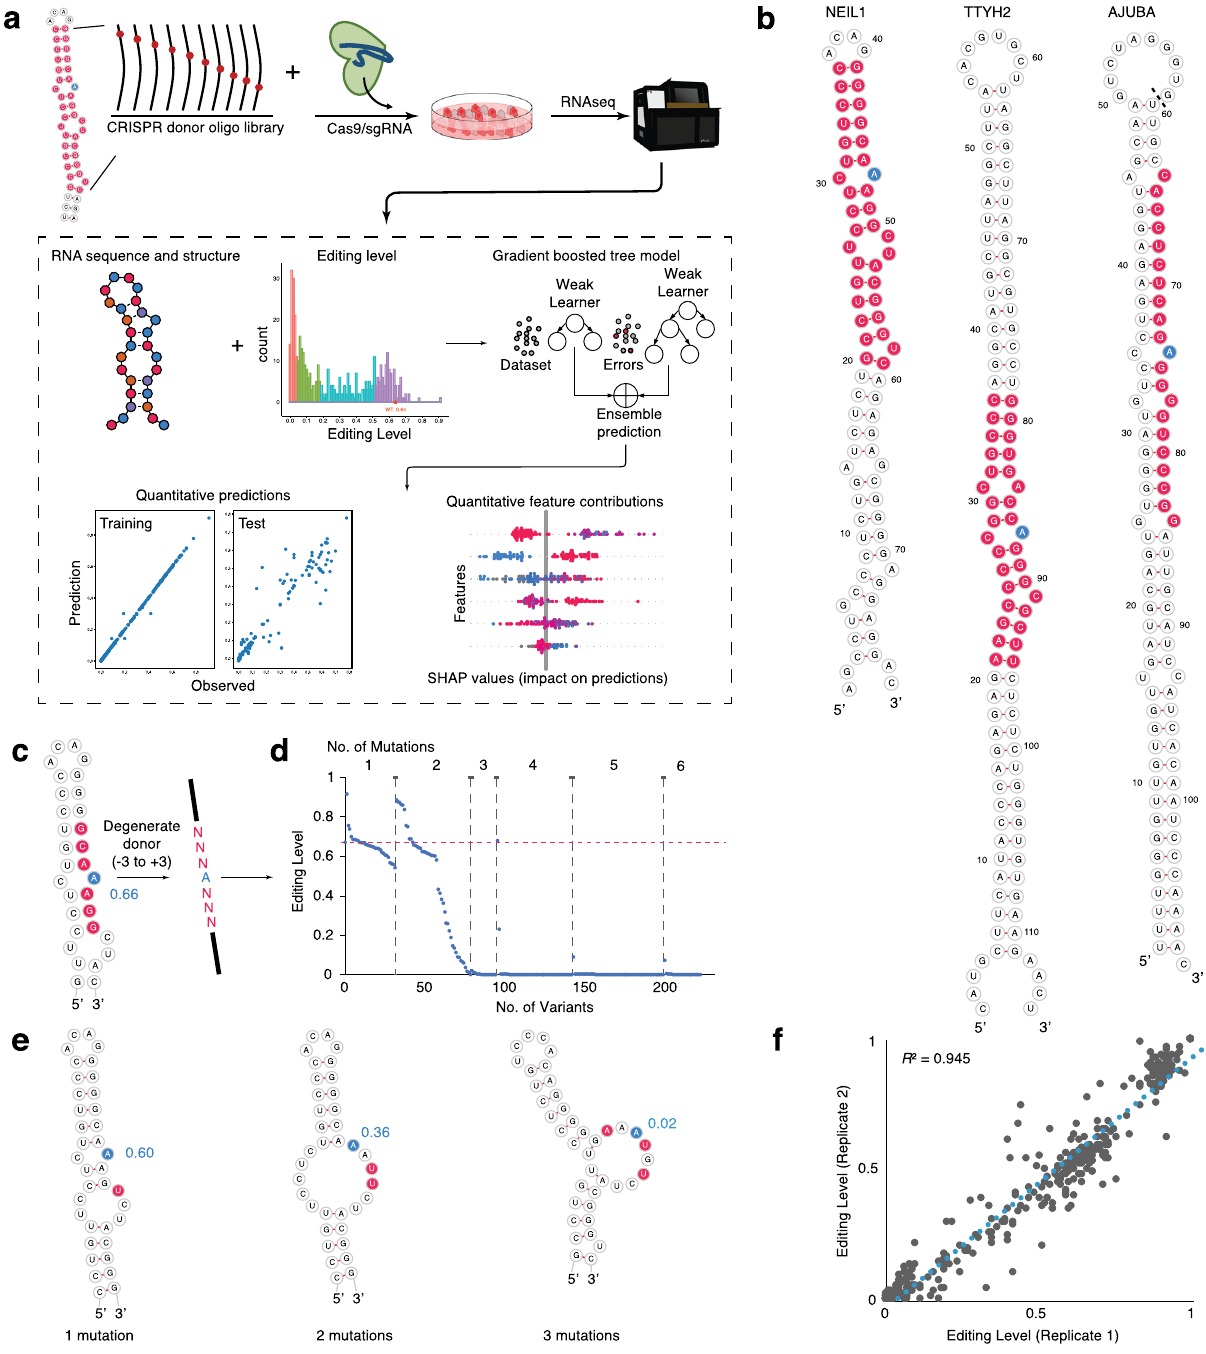
NATURE COMMUNICATIONS| (2021) 12:2165 |https://doi.org/10.1038/s41467-021-22489-2|www.nature.com/naturecommunications